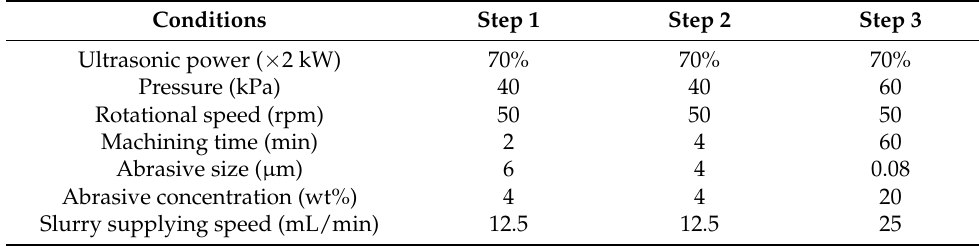
Table 3. The main machining conditions in the ultrasonic hybrid processes for SiC.